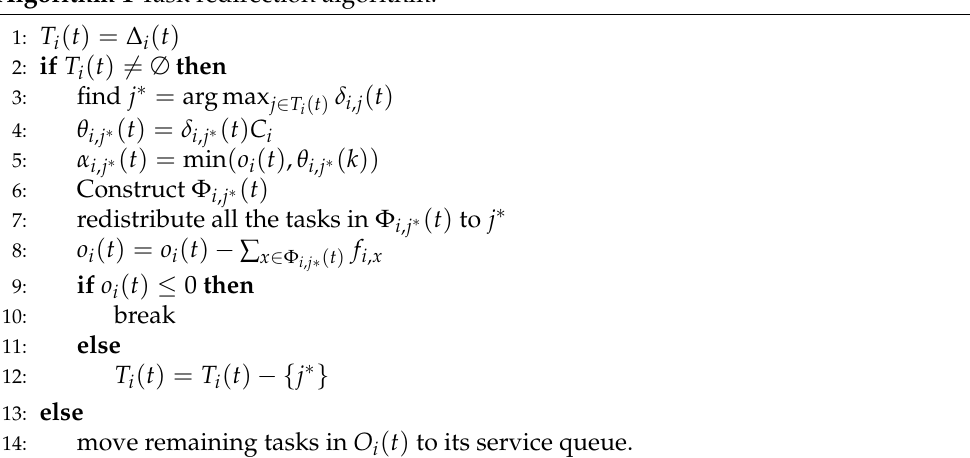
Algorithm 1 Task redirection